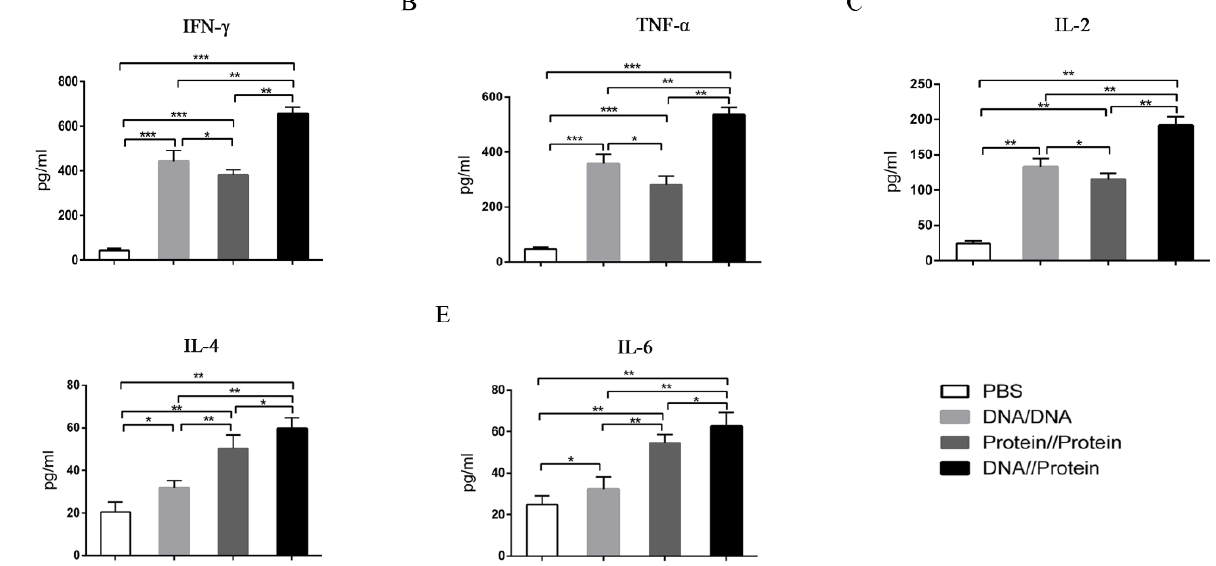
Figure 6 . Detection of various cytokines in mouse splenocyte cultures on day 35 after immunization. Splenocytes were isolated 14 days after the last immunization, and the concentrations of IFN- γ ( A ), TNF- α ( B ), IL-2 ( C ), IL-4 ( D ), and IL-6 ( E ) in the culture supernatant were detected using an ELISA kit. Data are expressed as mean ± standard error ( n = 10). * p < 0.05, ** p < 0.01 and *** p < 0.001.